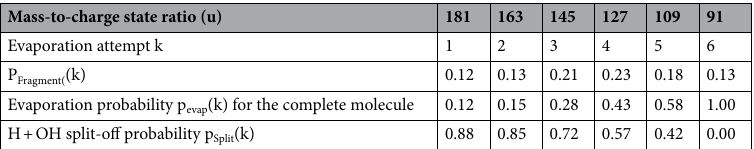
Mass-to-charge state ratio (u) 181 P Fragment(